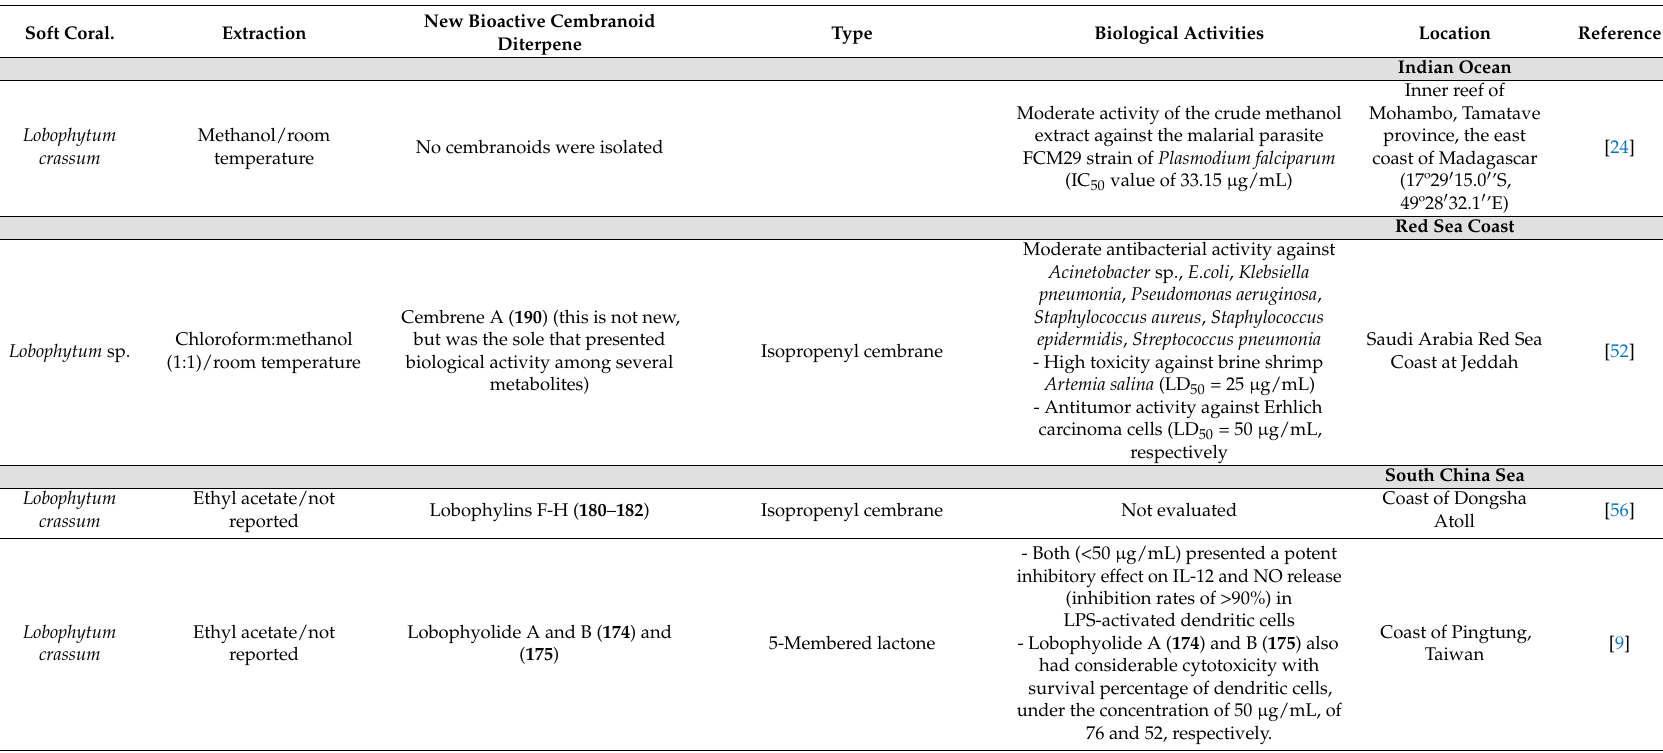
Table 4. Harvesting locations of the soft corals of the genus Lobophytum , extraction solvent, new compounds identified and their biological properties. Soft